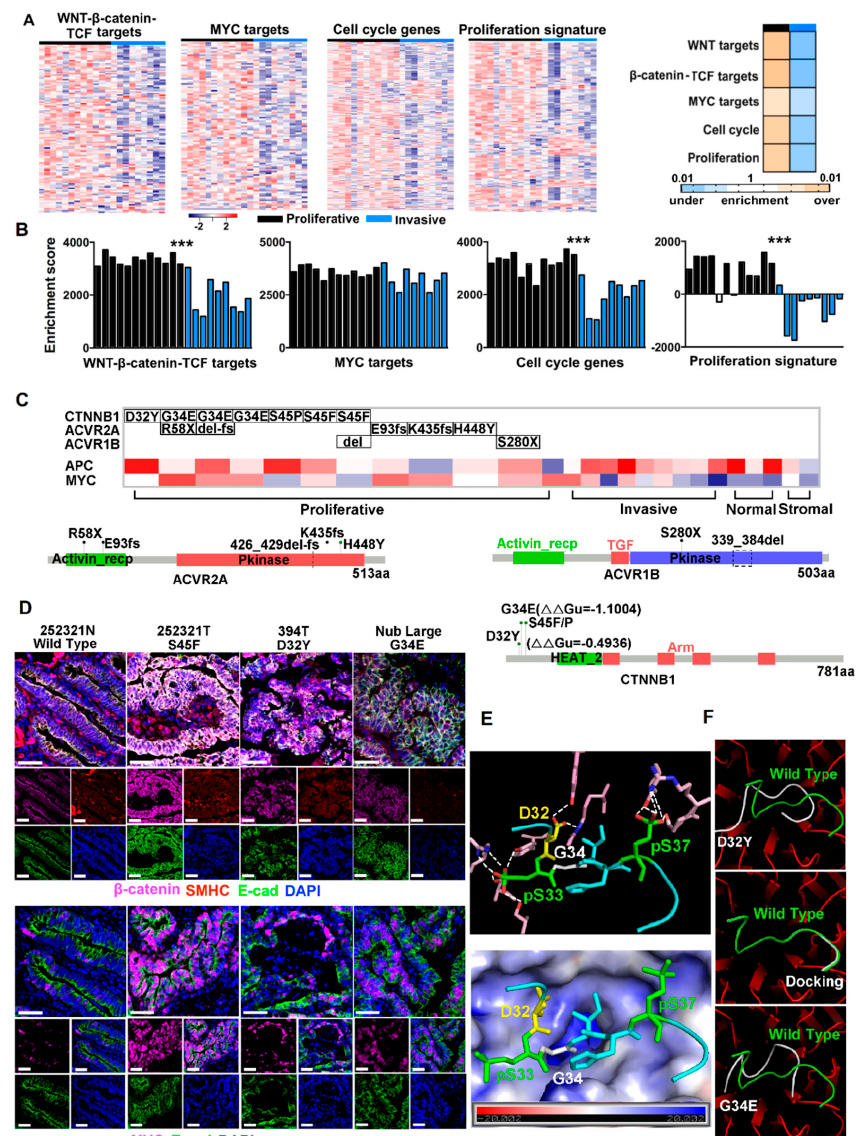
Figure 2. Proliferative tumors harbor activated WNT- β -catenin cell proliferation pathways and underlying gene mutations. ( A ) Left four heatmaps indicate higher expression levels, represented by log (cid:2870) (𝐹𝑃𝐾𝑀) , of gene signatures shown in proliferative tumors than invasive tumors, with their GSEA p-values specified by the right heatmap. ( B ) The bar plots indicate ssGSEA enrichment scores of the same gene signatures, reaching the same conclusion as (A), ***: p < 0.001. ( C ) Proliferative tumors harbor recurrent mutations of CTNNB1, ACVR2A and ACVR1B, as well as recurrent APC downregulation and MYC upregulation. Mutations of the three genes are shown at the bottom with their protein domains indicated. ∆∆ Gu, estimated as previously described [11], predicts if a missense mutation will alter the protein 3D structure. ( D ) Representative IHC images indicate the enrichment of cellular and nuclear β -catenin (top) and nuclear MYC (bottom) in tumor cells harboring CTNNB1 mutations. ( E ) The top 3D structure indicates that the phosphorylated N-terminal peptide of β -catenin binds β -TrCP1 through hydrogen bonds (dashed white lines) via D32, pS33 and pS37 of β -catenin. The bottom 3D structure indicates that the binding site locates in a positively charged pocket formed by β -TrCP1, and G34 of β -catenin locates at the center of the pocket. ( F ) Docking of β -catenin peptides to β -TrCP1 indicates that D32Y and G34E mutations alter substrate binding. The ground truth peptide binding in the crystal structure [37] is shown green, while peptide docking is shown in white. See also Figure S2, Table